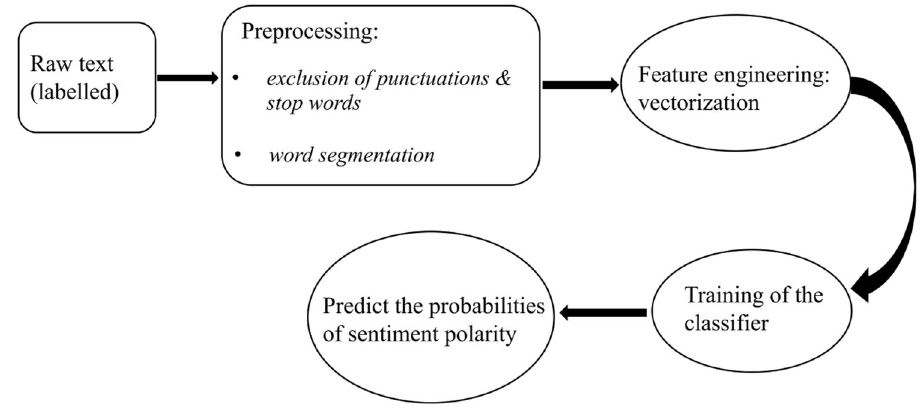
Fig. 1 Flowchart for Chinese sentiment analysis (adapted from Peng et al., 2017). The fi gure outlines the major steps of sentiment analysis for Chinese text. Particular attention should be paid to Chinese word segmentation as there is no space between words in written Chinese (see also Zhang & Wu, 2021).